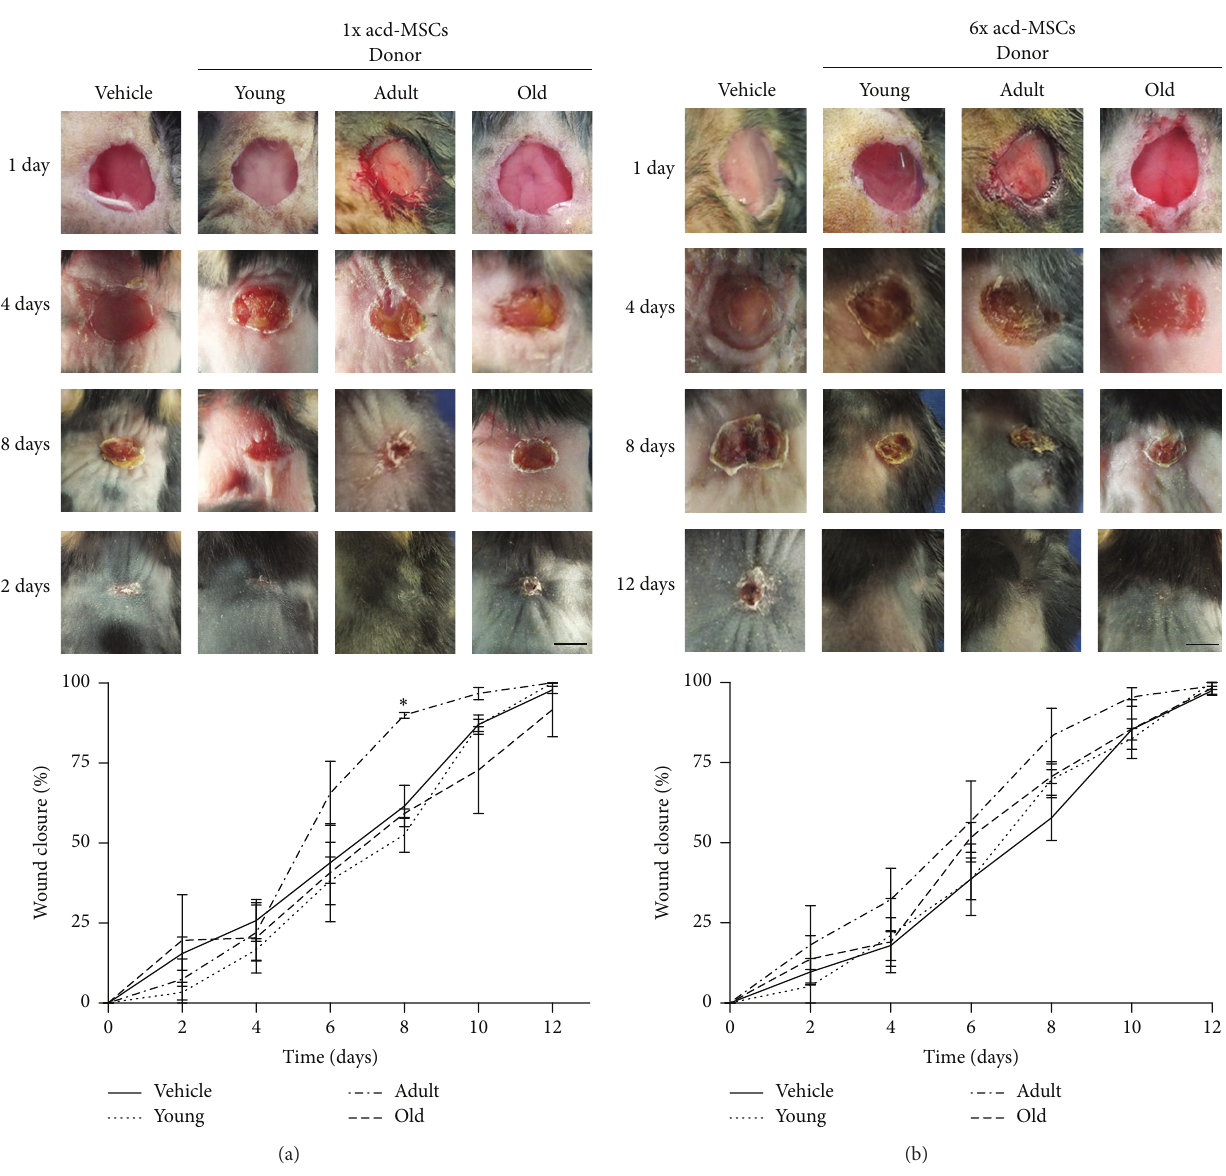
Figure 5: Adult donor acd-MSCs accelerated wound closure kinetics. Murine excisional wound model in which wounds were treated with (a) 1x dose and (b) 6x dose of acd-MSCs from young, adult, and old donors’ BM-MSCs or Alpha-MEM medium (vehicle).